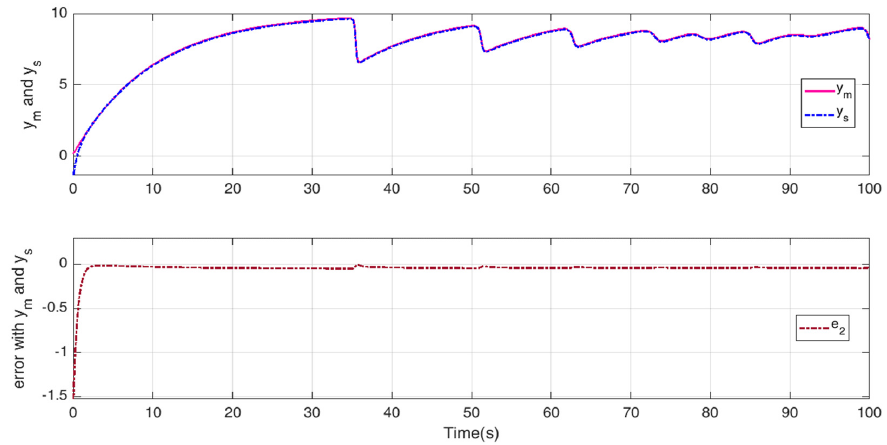
Figure 7. The master–slave synchronization of the second state.